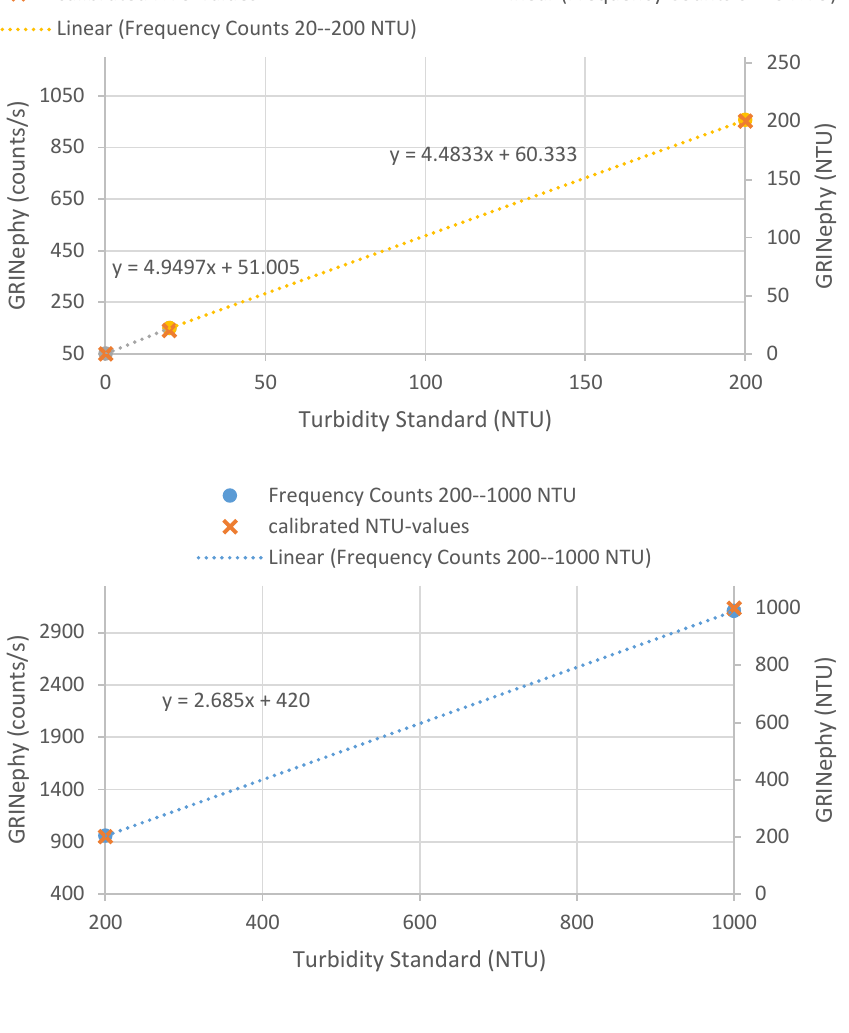
Figure 2. Calibration of GRINephy: ( top ) Output frequency signals of our GRINephy given in counts/s for measuring formazin turbidity calibration standards with the NTU values 0.1, 20, and 200 (gray and yellow dots). ( bottom ) Sub-region of 200–1000 NTU with the output frequency of our GRINephy using 200 and 1000 NTU calibration standards. The orange crosses show in both figures the converted NTU